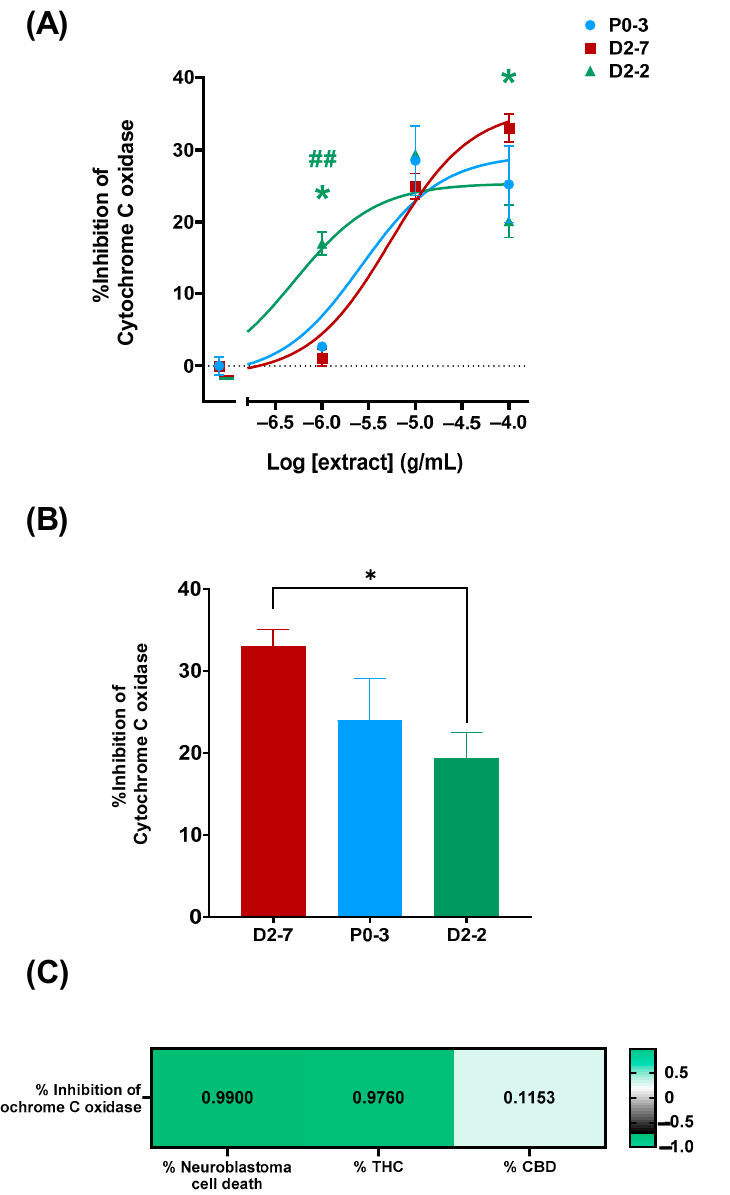
a positive correlation between the quantity of tetrahydrocannabinol and cell death. The quantity of cannabidiol did not show a correlation with cell death.